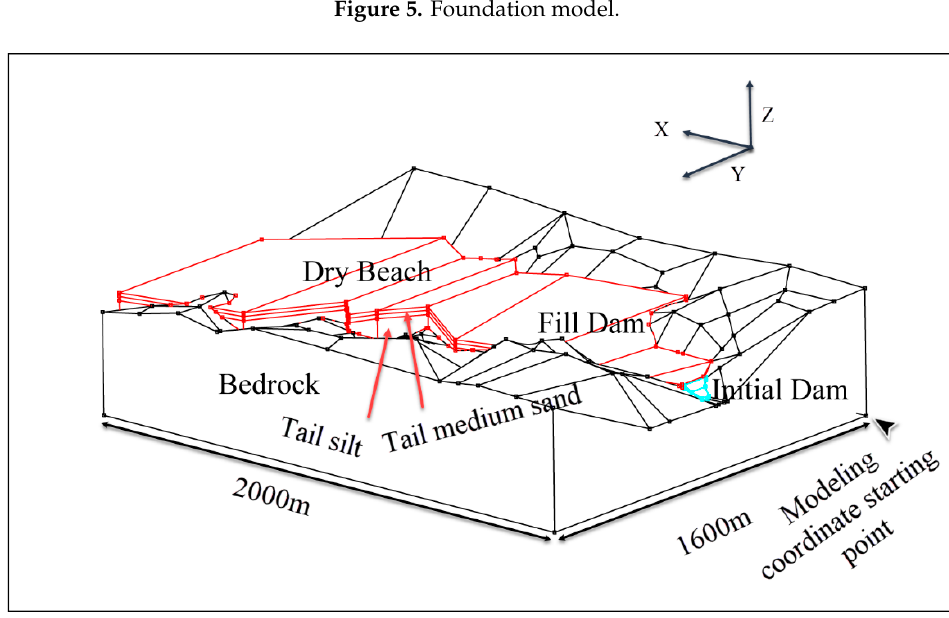
Figure 6. The 3d model of tailings dam.